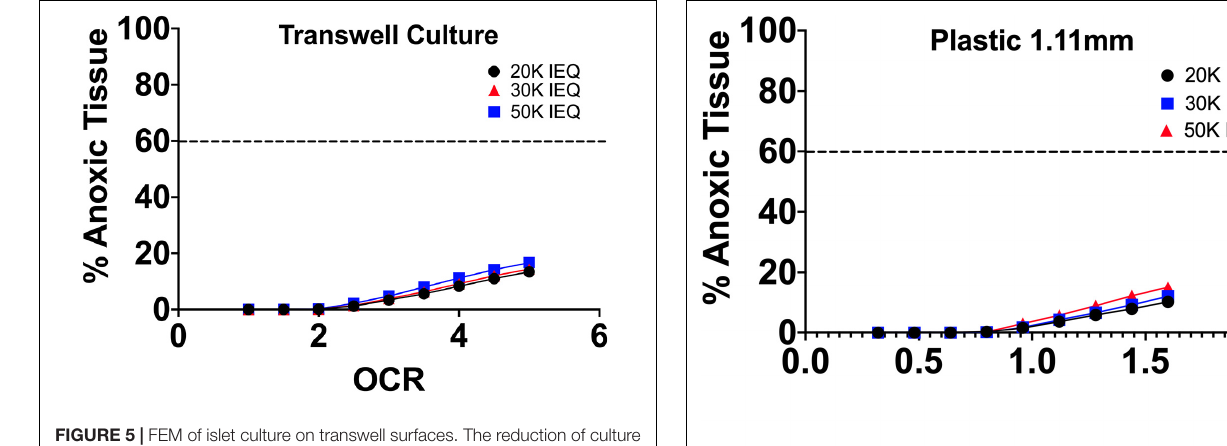
FIGURE 5 | FEM of islet culture on transwell surfaces. The reduction of culture medium height due to closer proximity of the islets to the liquid/gas interface and the imposed distance from the gas impermeable basal surface (plastic) results in significant drops in tissue hypoxia/anoxia at all oxygen consumption rates.